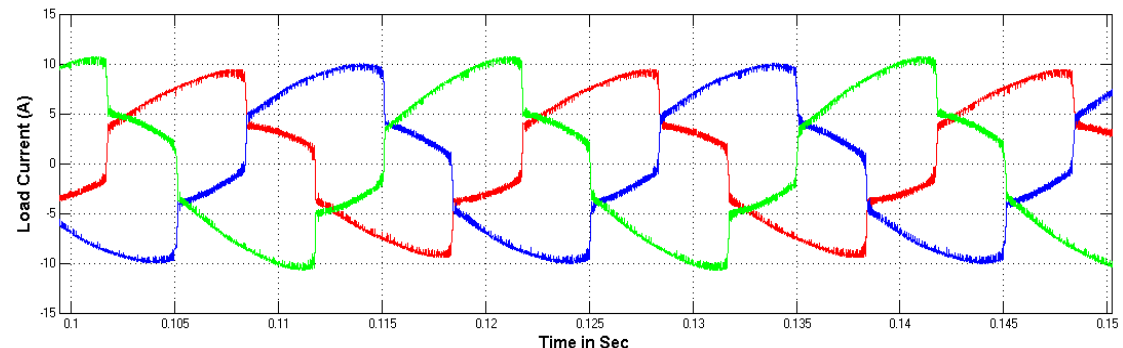
Figure 27. Nonlinear load